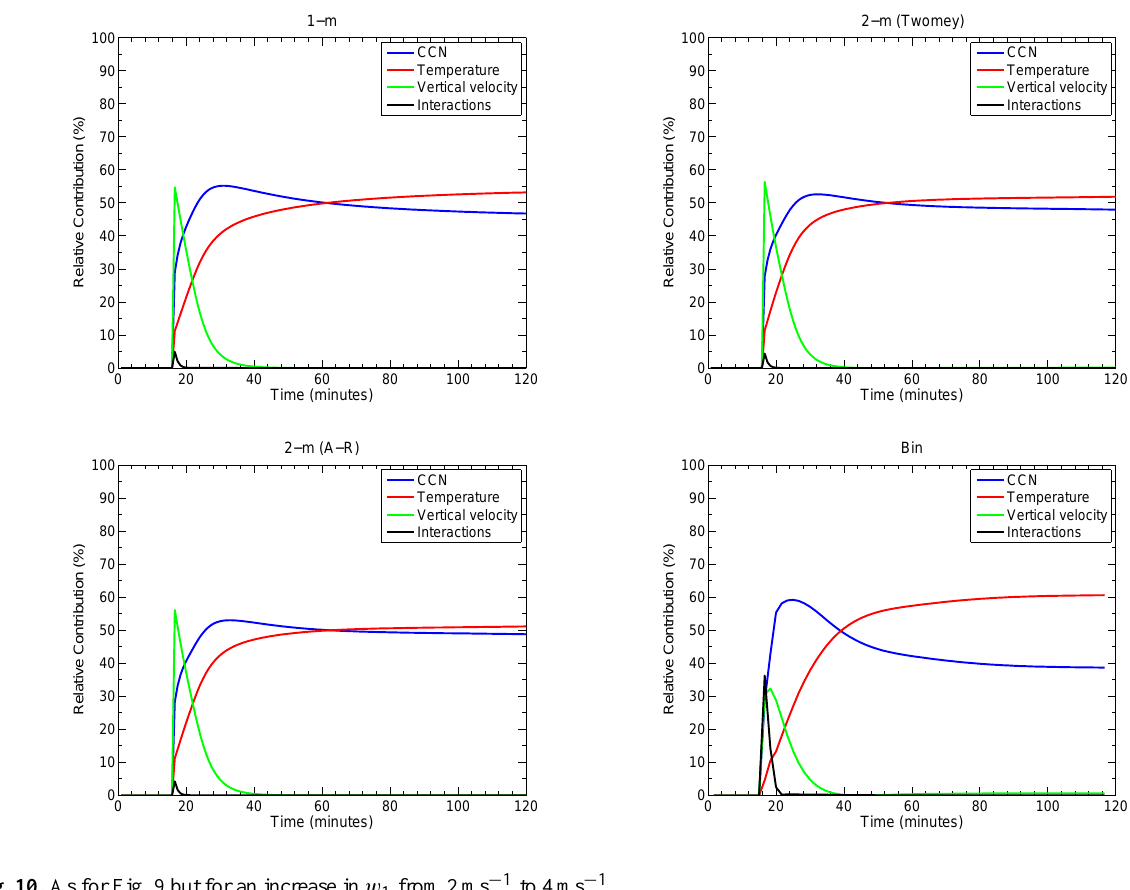
from 2 ms − 1 to 4 ms − 1 . 1